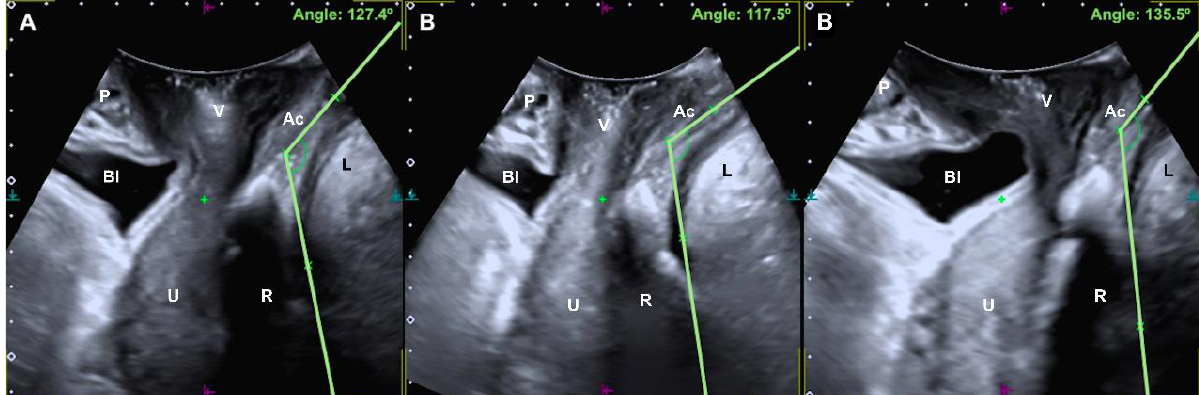
Figure 1. A, Anorectal angle at rest ( A ), with maximum contraction ( left B ) and with the Valsalva maneuver ( right B ). P, pubic bone; Bl, bladder; V, vagina; U, uterus; R, rectal ampulla; Ac, anal canal; L, levator ani muscle.